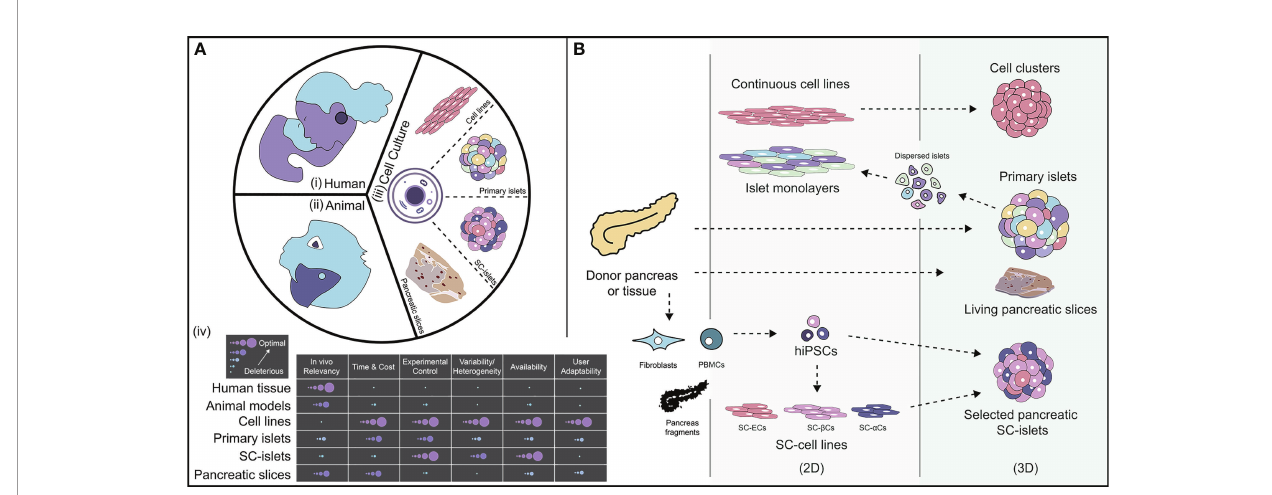
FIGURE 2 | The landscape of how diabetes is studied and cell sources available for researchers. [ A (i-iii)]: Currently available models to study diabetes, such as human clinical trials, animal pre-clinical models, and in vitro cell culture systems. [ A -(iv)] Relative breakdown of different characteristics of each available model for diabetes to highlight key advantages and disadvantages. (B) An outlook of available cell sources for diabetes modeling separated by 2D and 3D morphology. PBMCs, peripheral blood mononuclear cells; hiPSCs, human induced pluripotent stem cells; SC, Stem cell-derived; ECs, endothelial cells; b Cs, b -like-cells; a Cs, a -like-cells. Illustration not drawn to